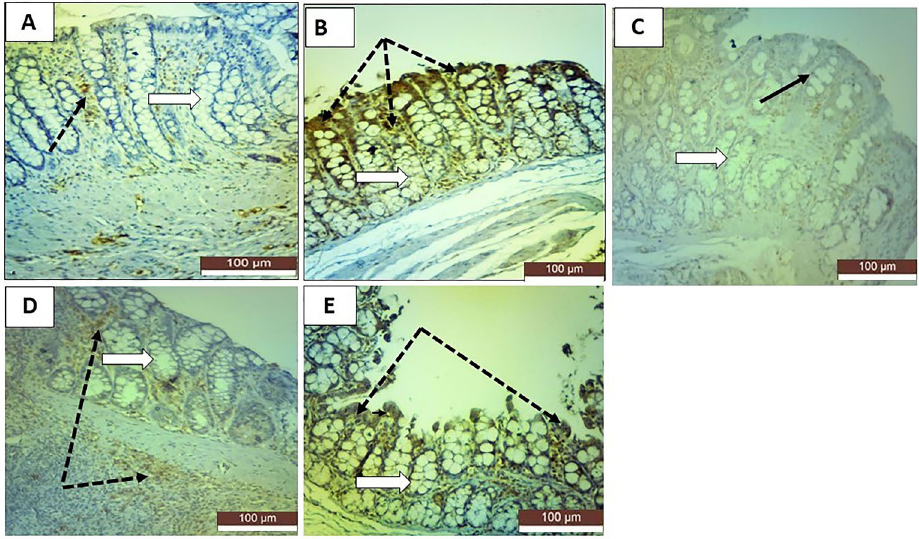
Figure 6. Photomicrographs of rat colonic sections stained for TNF- a immunoexpression in the mucosa ( (cid:4) 20, scale bar 100 m m). A , The normal control group shows negative reactions in the crypt cells and goblet cells (white arrow), except for a few cells in the connective tissue lamina (dotted black arrow). B , The positive control group shows highly positive reactions in the degenerated crypt cells (white arrow) and in fl ammatory cells between the crypts (dotted black arrows). C , The sulfasalazine group shows very faint positive reactions in the surface cells (black arrow) and crypt cells (white arrow). D , The oral ro fl umilast group shows moderately positive reactions in the surface cells (dotted black arrows) and crypt cells (white arrow). E , The rectal ro fl umilast group shows strong positive reactions in crypt cells (white arrow) and degenerated cells (dotted black